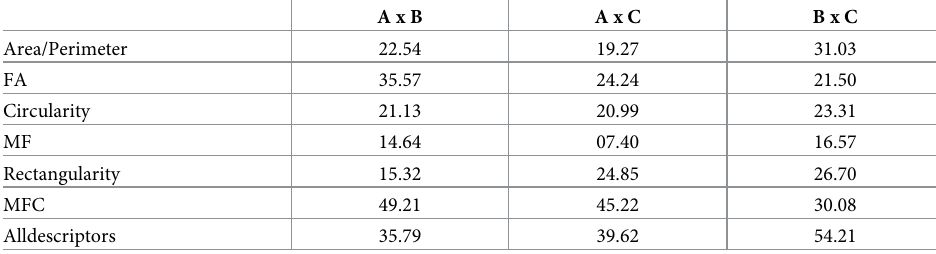
A x B A x C B x